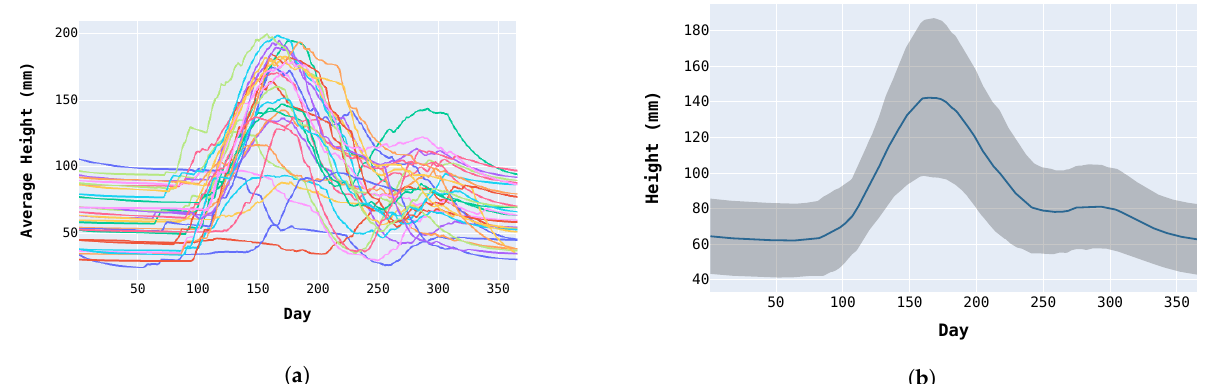
Figure 1. ( a ) Average pasture height and ( b ) mean and standard deviation of the 30 years of historical data across three sites in Iowa from APSIMs Met module are shown for each day of the